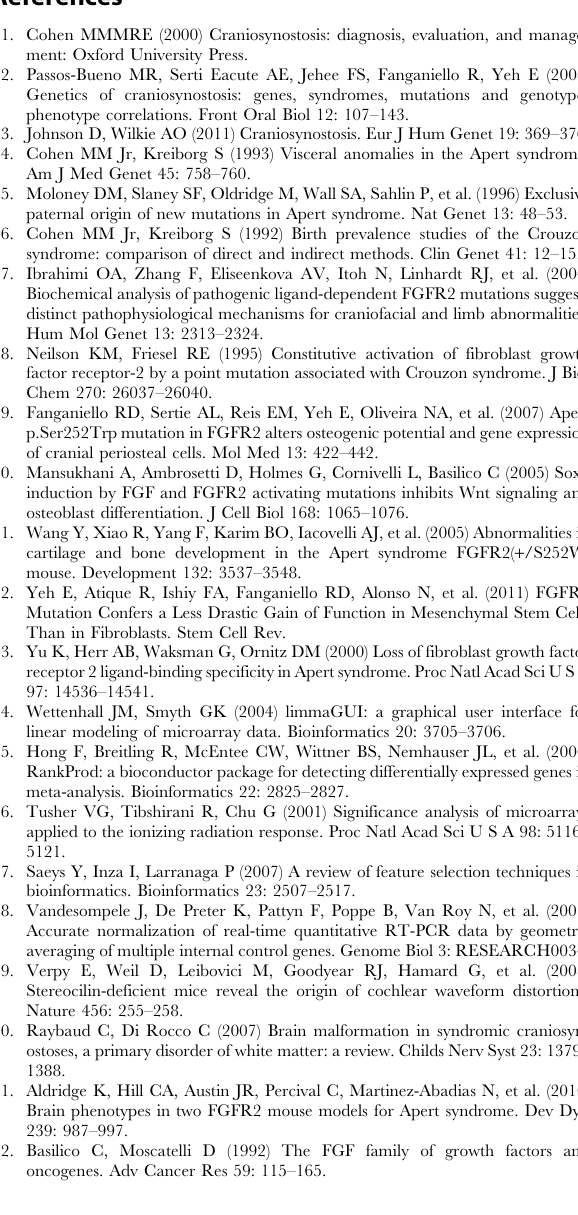
Table S3 Differentially expressed transcripts in FGF2 - treated S252W fibroblasts compared to the same samples without treatment. In each treatment, transcripts are ordered by average Fold change ratio (treated vs non-treated) of the